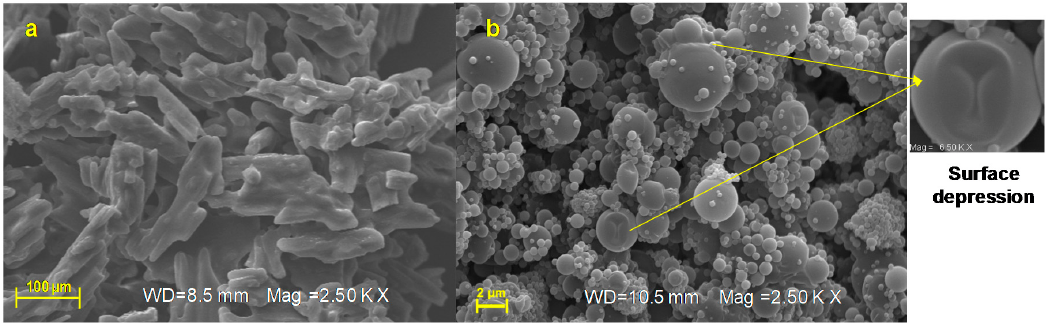
Figure 4. Scanning electron microscopy (SEM) micrographs (magnification: 2.5 KX, frame average, n = 1) of raw extract (AJ, ( a )) and loaded powder (AJEP 3 , ( b )) at t 0.